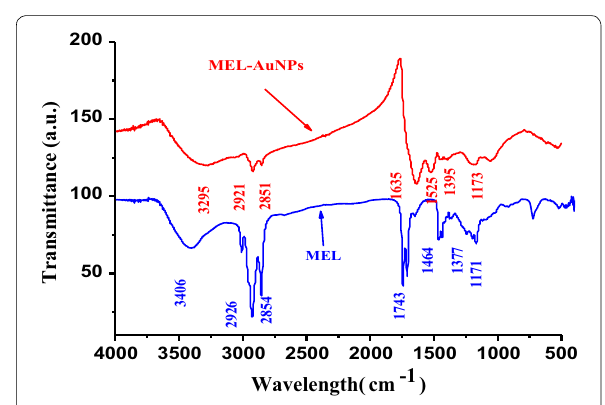
4000 3500 3000 2500 2000 1500 1000 Fig. 4 FTIR spectrum of MEL-AuNPs and